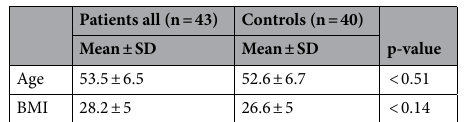
Table 1. Clinical data compared between patients and controls.